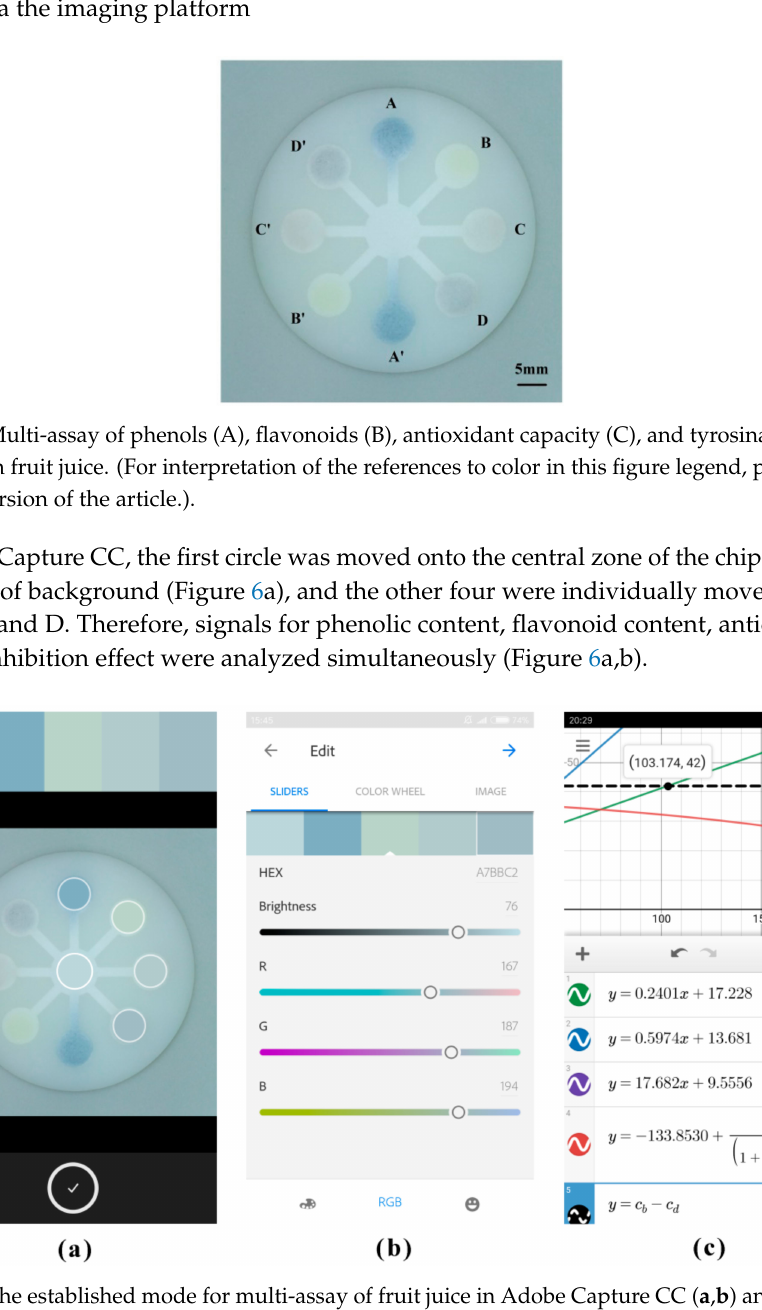
Figure 6. The established mode for multi-assay of fruit juice in Adobe Capture CC ( a , b ) and Desmos ( c ) on the smartphone. (For interpretation of the references to color in this figure legend, please refer to the web version of the